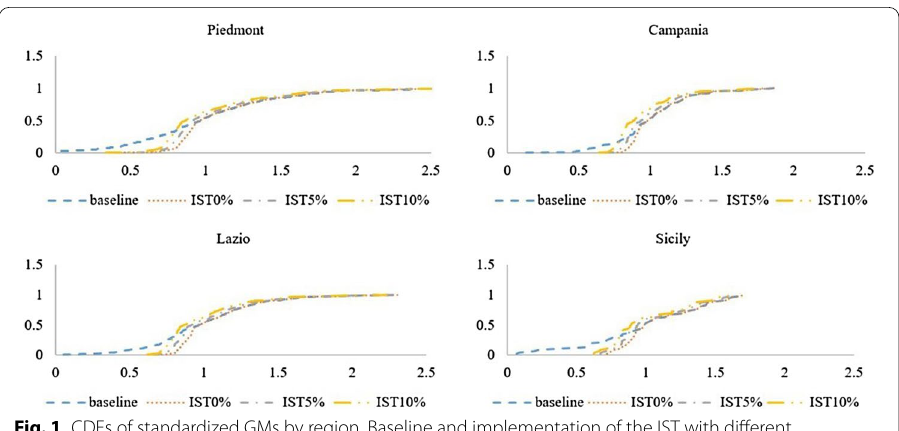
Fig. 1 CDFs of standardized GMs by region. Baseline and implementation of the IST with different contribution rates